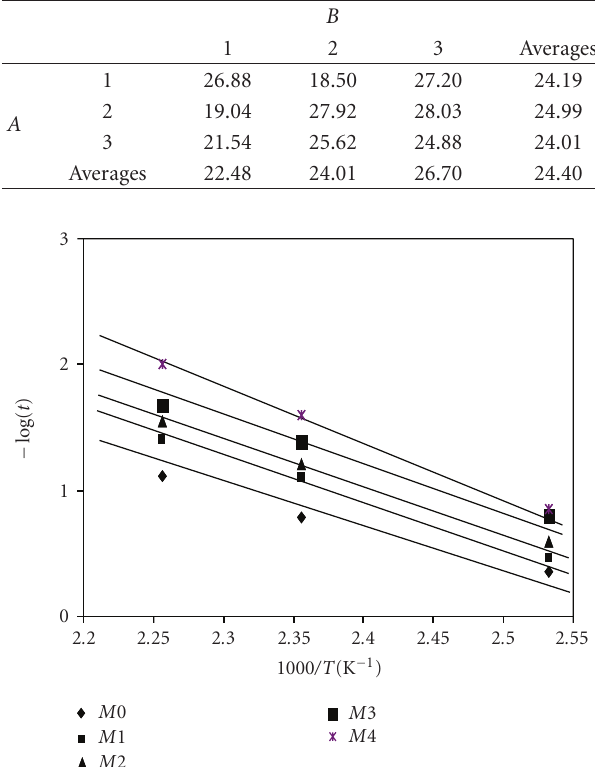
Figure 2: Arrhenius plots curing natural rubber.